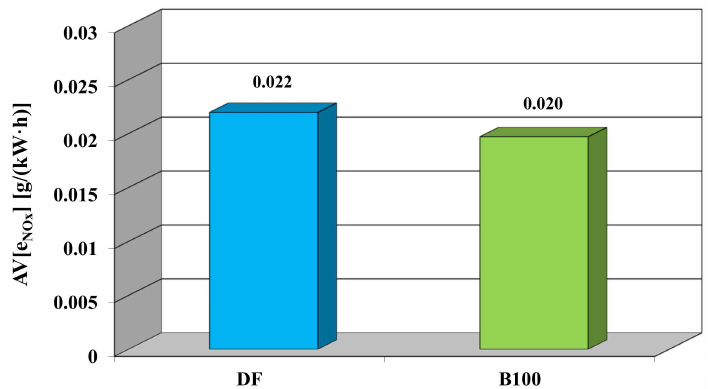
Figure 11. Average value—AV in the speed domain of the specific brake emissions of nitrogen oxides—e NOx for the engine powered with fuels DF diesel or B100.